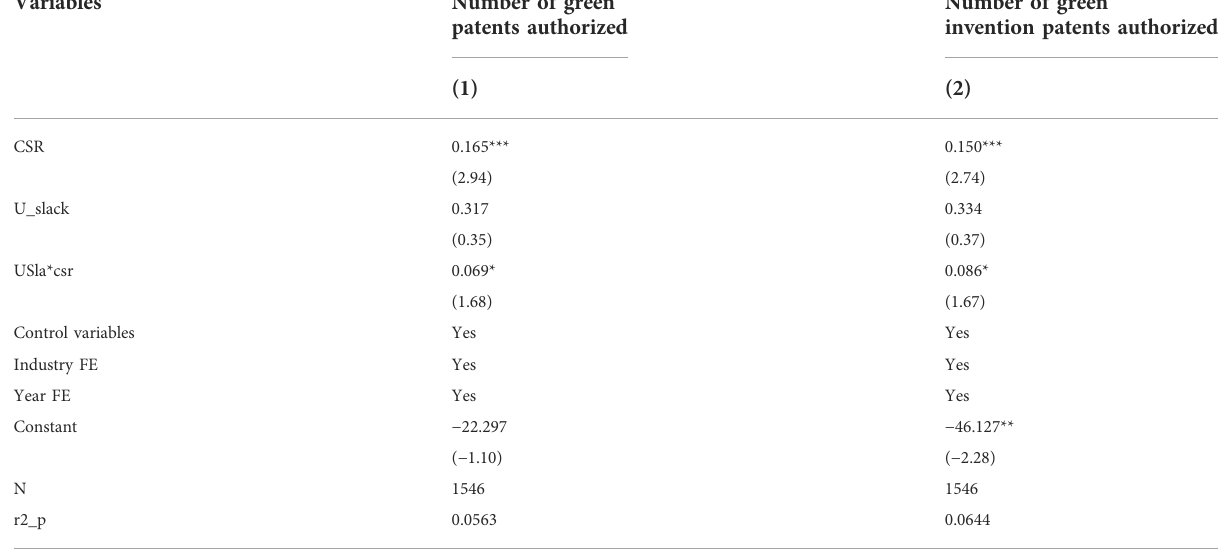
TABLE 7 Changing the measurement of the independent variables.